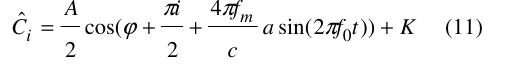
Figure 1a. Experiment setup